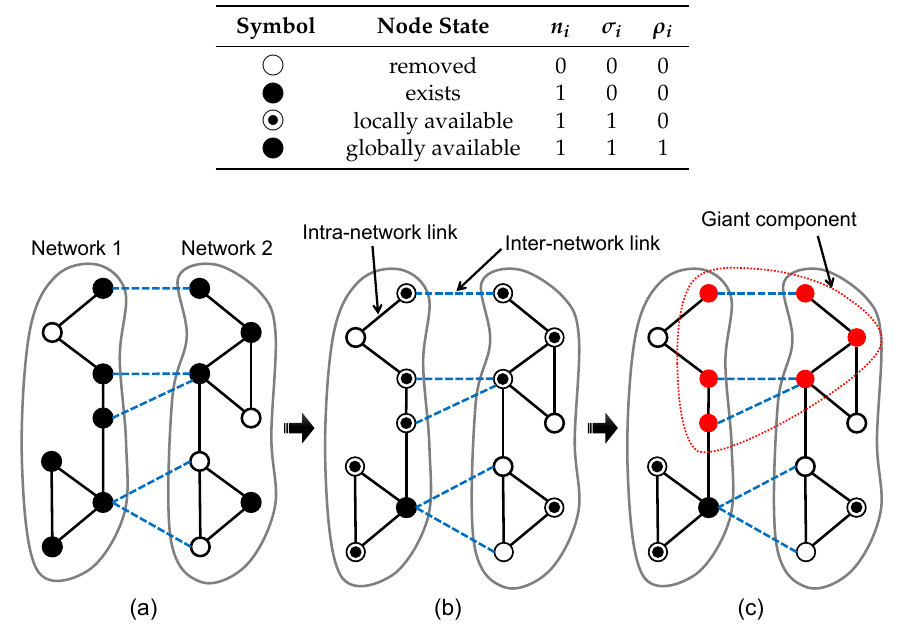
Table 1. Definition of network-of-networks (NoN) node states.